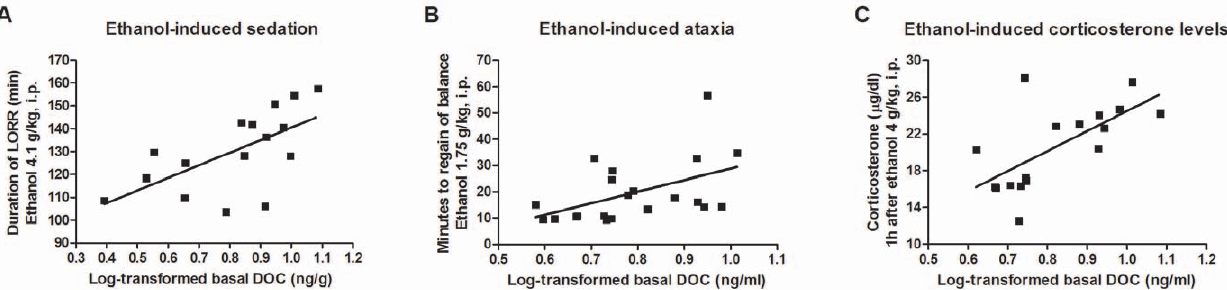
Figure 3. Genetic correlations between basal cerebral cortical or plasma DOC levels and behavioral phenotypes for ethanol sensitivity previously characterized in the BXD strains. Behavioral data for ethanol sensitivity has been collected by multiple independent labs and has been obtained from GeneNetwork (www.genenetwork.org). A) Pearson’s r =0.63, p =0.008, Spearman’s r =0.64, p =0.006, n =16; Rodriguez et al. , 1994, GN ID 10586. B) Pearson’s r =0.49, p =0.024, Spearman’s r =0.57, p =0.006, n =21; Kirstein et al. , 2002, GN ID 10350. C) Pearson’s r =0.67, p =0.003, Spearman’s r =0.73, p =0.0005, n =17; Roberts et al. , 1995, GN ID 10573.